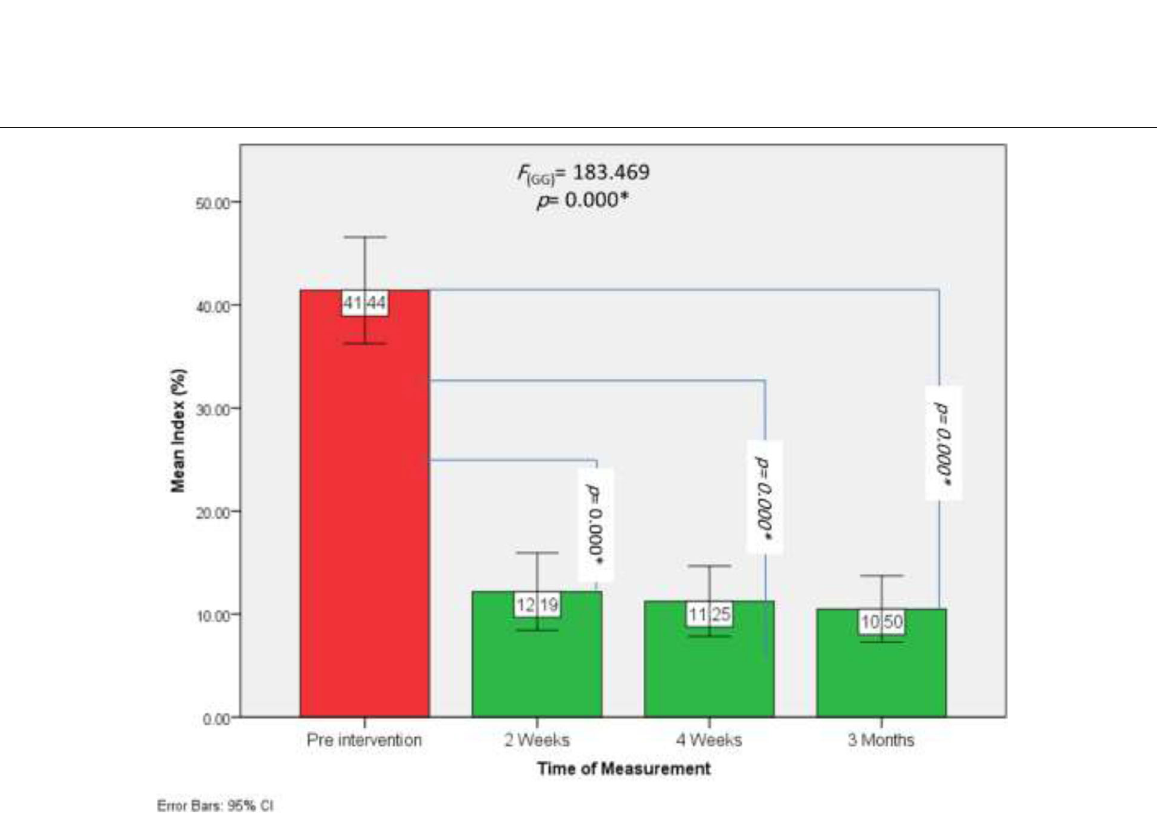
Fig. 13 Bar chart with 95% CI error bar, comparison between pre- and post-intervention Oswestry disability